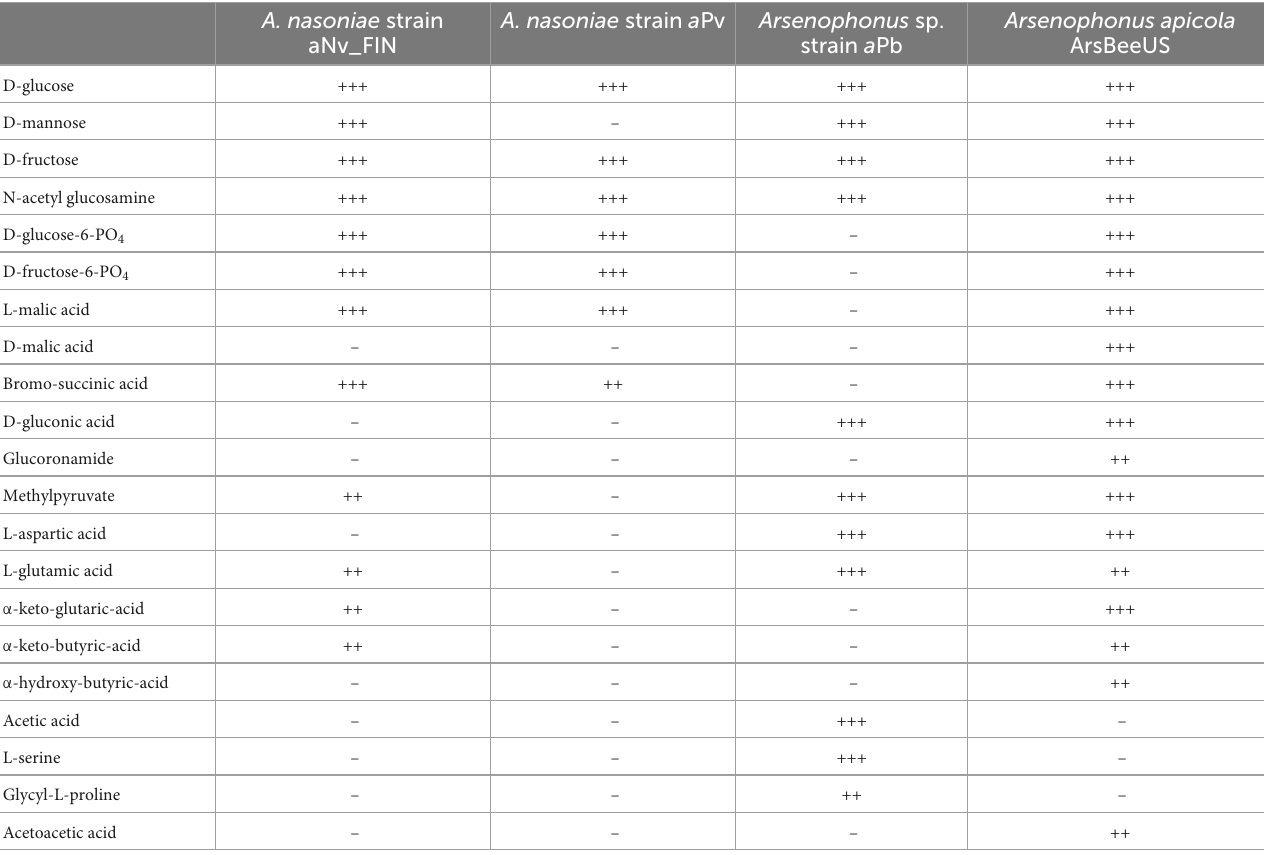
TABLE 1 Carbon utilization sources for diverse Arsenophonus strains as estimated from biolog plate analysis: A. nasoniae a Nv_FIN, A. nasoniae a Pv (from P. vindemmiae ), Arsenophonus sp. strain a Pb (from P. bellargus